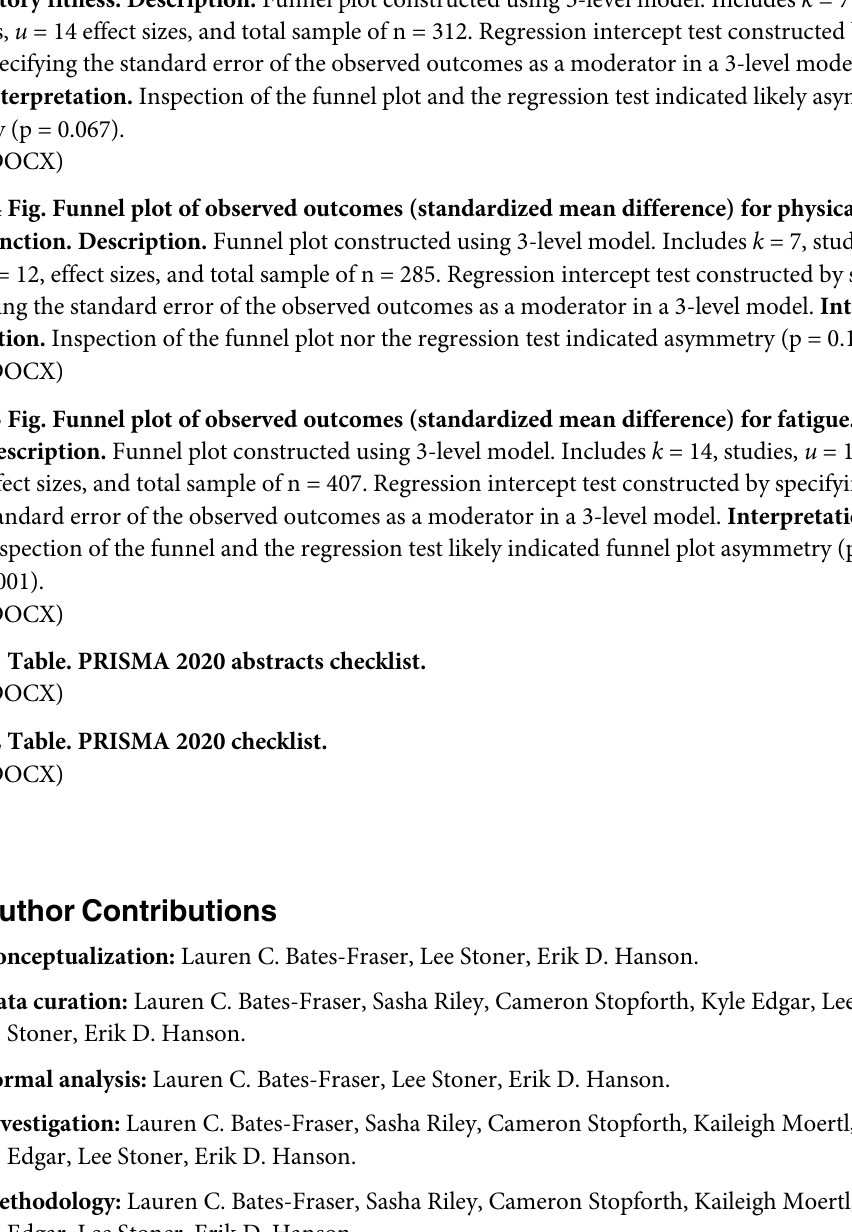
S3 Fig. Funnel plot of observed outcomes (standardized mean difference) for cardiorespi- ratory fitness. Description. Funnel plot constructed using 3-level model. Includes k = 7 stud- ies, u = 14 effect sizes, and total sample of n = 312. Regression intercept test constructed by specifying the standard error of the observed outcomes as a moderator in a 3-level model. Interpretation. Inspection of the funnel plot and the regression test indicated likely asymme- try (p = 0.067). S4 Fig. Funnel plot of observed outcomes (standardized mean difference) for physical function. Description. Funnel plot constructed using 3-level model. Includes k = 7, studies, u = 12, effect sizes, and total sample of n = 285. Regression intercept test constructed by speci- fying the standard error of the observed outcomes as a moderator in a 3-level model. Interpre- tation. Inspection of the funnel plot nor the regression test indicated asymmetry (p = 0.174). S5 Fig. Funnel plot of observed outcomes (standardized mean difference) for fatigue. Description. Funnel plot constructed using 3-level model. Includes k = 14, studies, u = 18 effect sizes, and total sample of n = 407. Regression intercept test constructed by specifying the standard error of the observed outcomes as a moderator in a 3-level model. Interpretation. Inspection of the funnel and the regression test likely indicated funnel plot asymmetry (p < 0.001). S1 Table. PRISMA 2020 abstracts checklist. S2 Table. PRISMA 2020